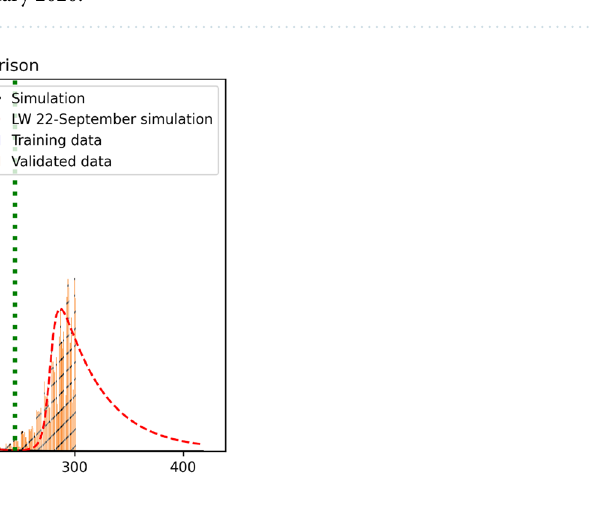
Figure 8. Infection kinetics compared for India for different lockdown withdrawal dates. Analysis is based on daily mortality statistics. The vertical dotted line represents lockdown withdrawal date t 0 in the function L ( t ) (see “Lockdown Dynamics” in “Methods” section). For the left and right panels t 0 is set to be 31 July 2020 and 31 August 2020, respectively. k = 20 and α = 1.9 are used in the function L ( t ) for simulating red dashed curves in both the plots. Here “0” marks 22 January 2020.